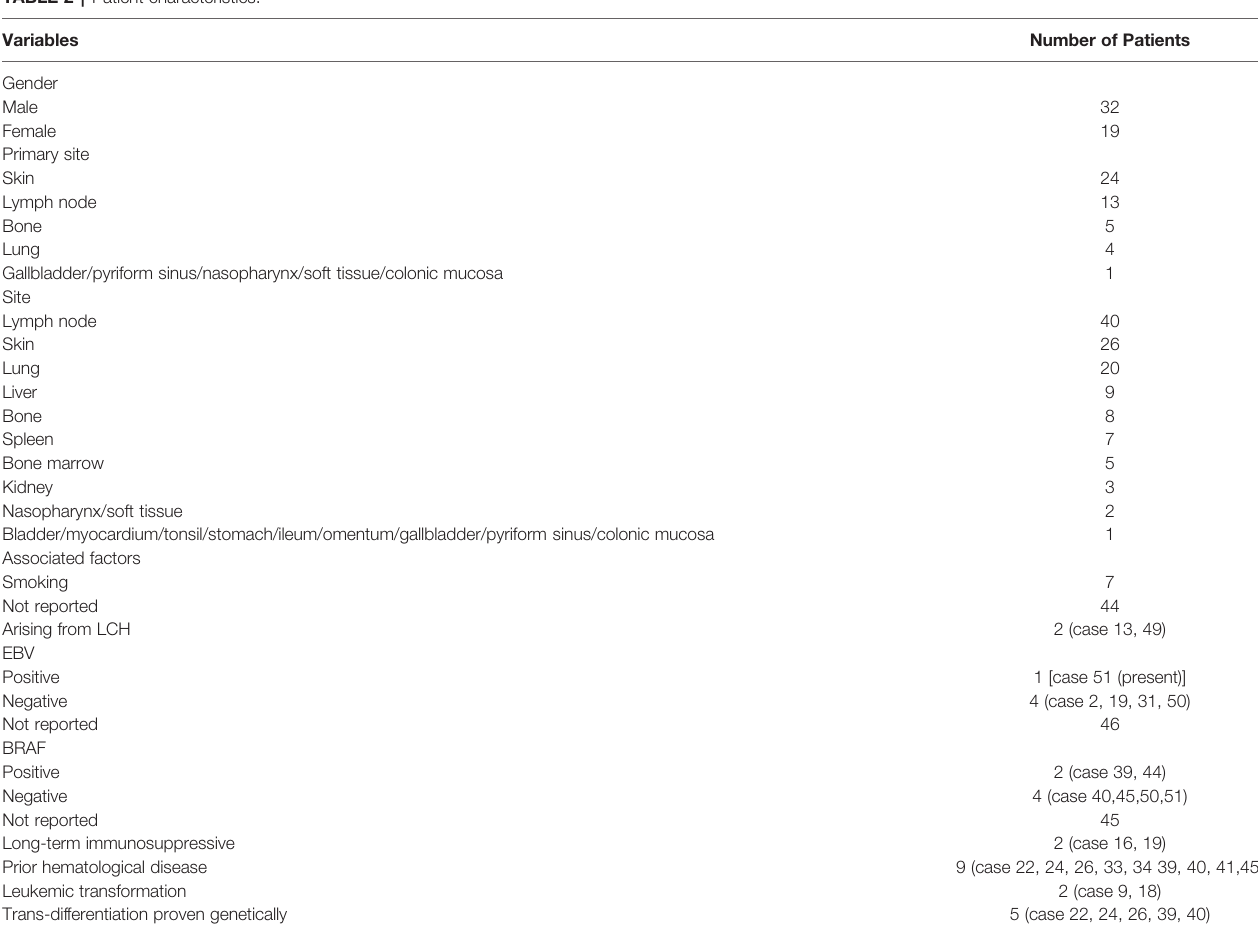
TABLE 2 | Patient